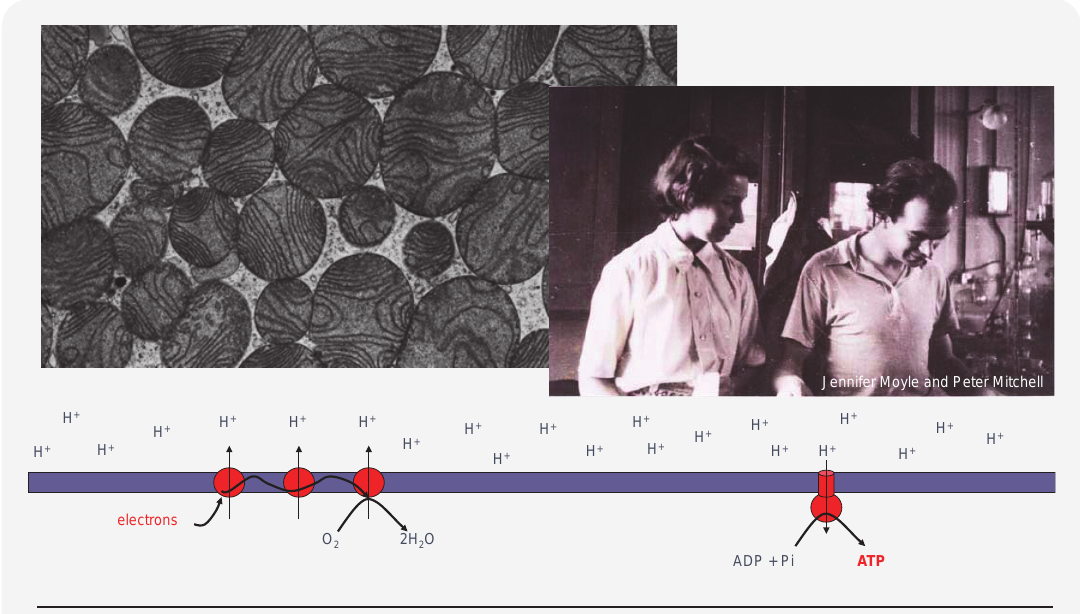
Figure 4. Mitochondria showing the cristae membranes where respiration takes place. The mechanism of respiration, known as chemi- osmotic coupling, was elucidated by Peter Mitchell in collaboration with Jennifer Moyle and others. The cartoon shows the mechanism of chemiosmotic coupling, in which the fl ow of electrons from ‘food’ to oxygen within the membrane powers the extrusion of protons across the membrane; the fl ow of protons through the ATP synthase, a kind of turbine, powers the synthesis of ATP, the universal energy currency of